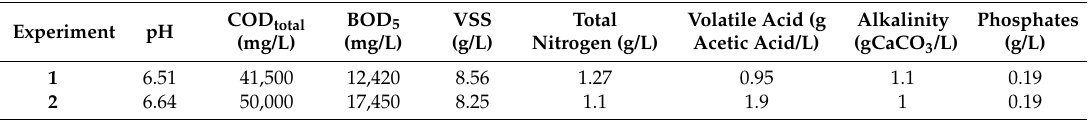
Table 7. Characterization of the influent substrate in experiments.